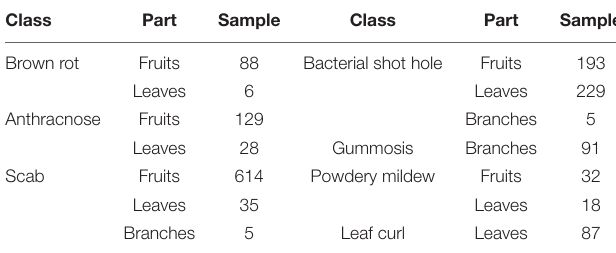
TABLE 1 | Classification of peach disease image dataset.